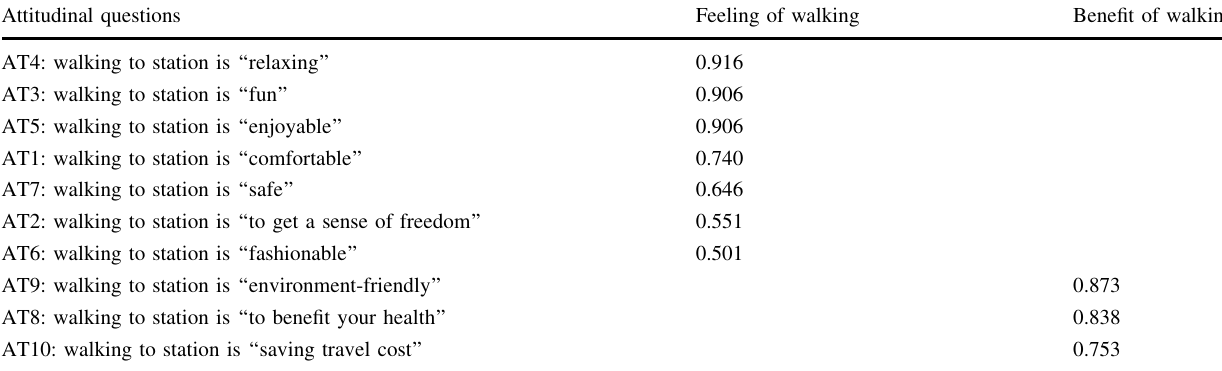
Table 5 Exploratory factor analysis results Attitudinal questions Feeling of